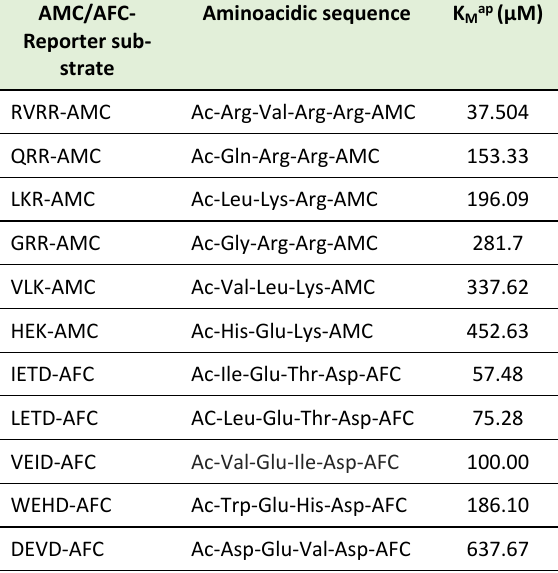
FIGURE 4. MCs im- munodetection in D. tertiolecta during dark-induced CD (A) ; Percentage of dead cells based on Sytox- green staining for seven days dark- induced CD in D. tertiolecta cultures (B) . Symbols are means of measure- ments of two inde- pendent replicate cultures and three replicate samples from each culture cylinder. Error bars indicate standard